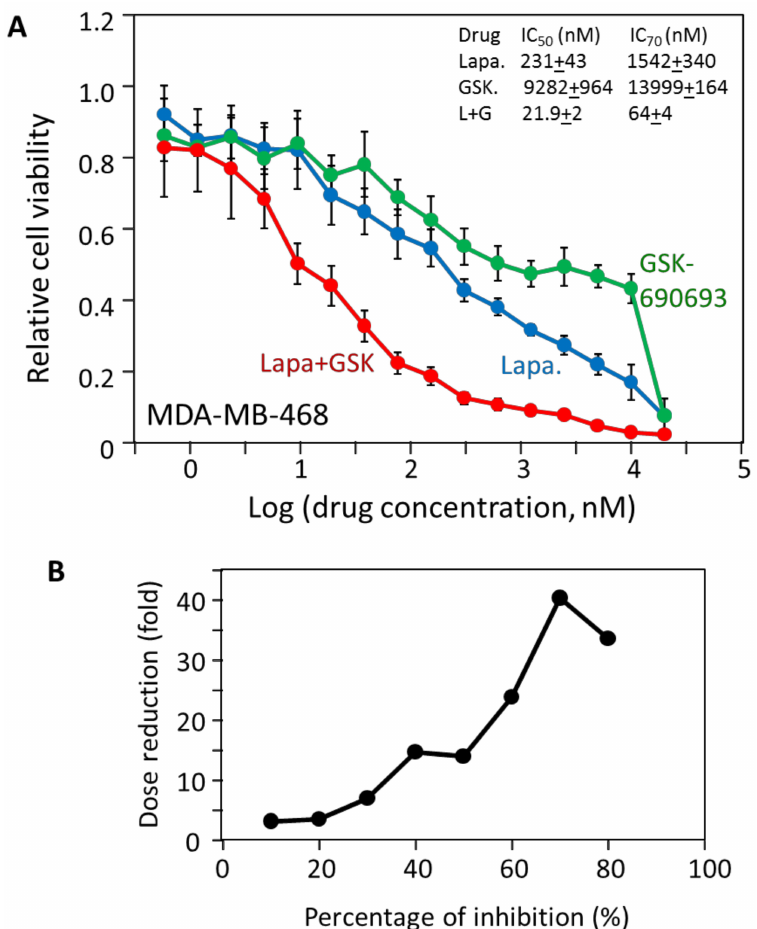
Figure 4. Synergistic inhibition of MDA-MB-468 cell viability by lapatinib and GSK690693. ( A ) The individual responses of MDA-MB-468 cells to lapatinib and GSK690693 are compared to the response of MDA-MB-468 cells to the combination of both drugs at equal molar concentrations; ( B ) synergistic dose reduction of lapatinib and GSK690693 on MDA-MB-468 cells as a function of the percentage of viability inhibition. The results are representative of two independent experiments of